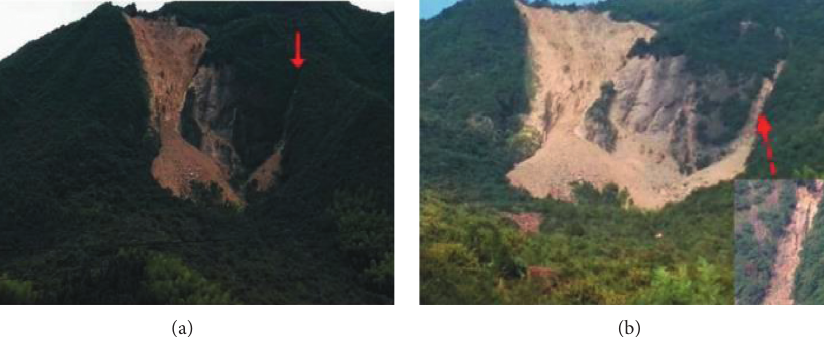
Figure 6: Avalanche movement continuous in the back of the source area. (a) Photo was taken on July 8, 2016. (b) Photo was taken on